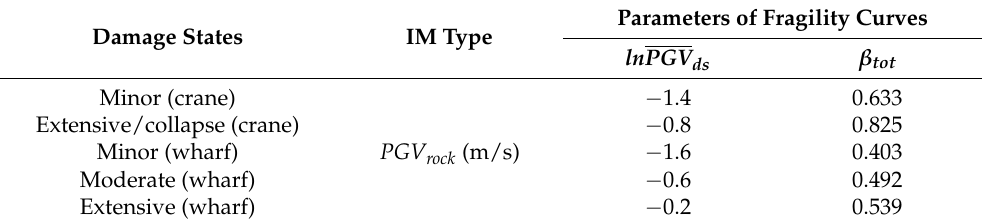
Table 3. Lognormal (ln) distribution parameters of the analytical fragility curves.